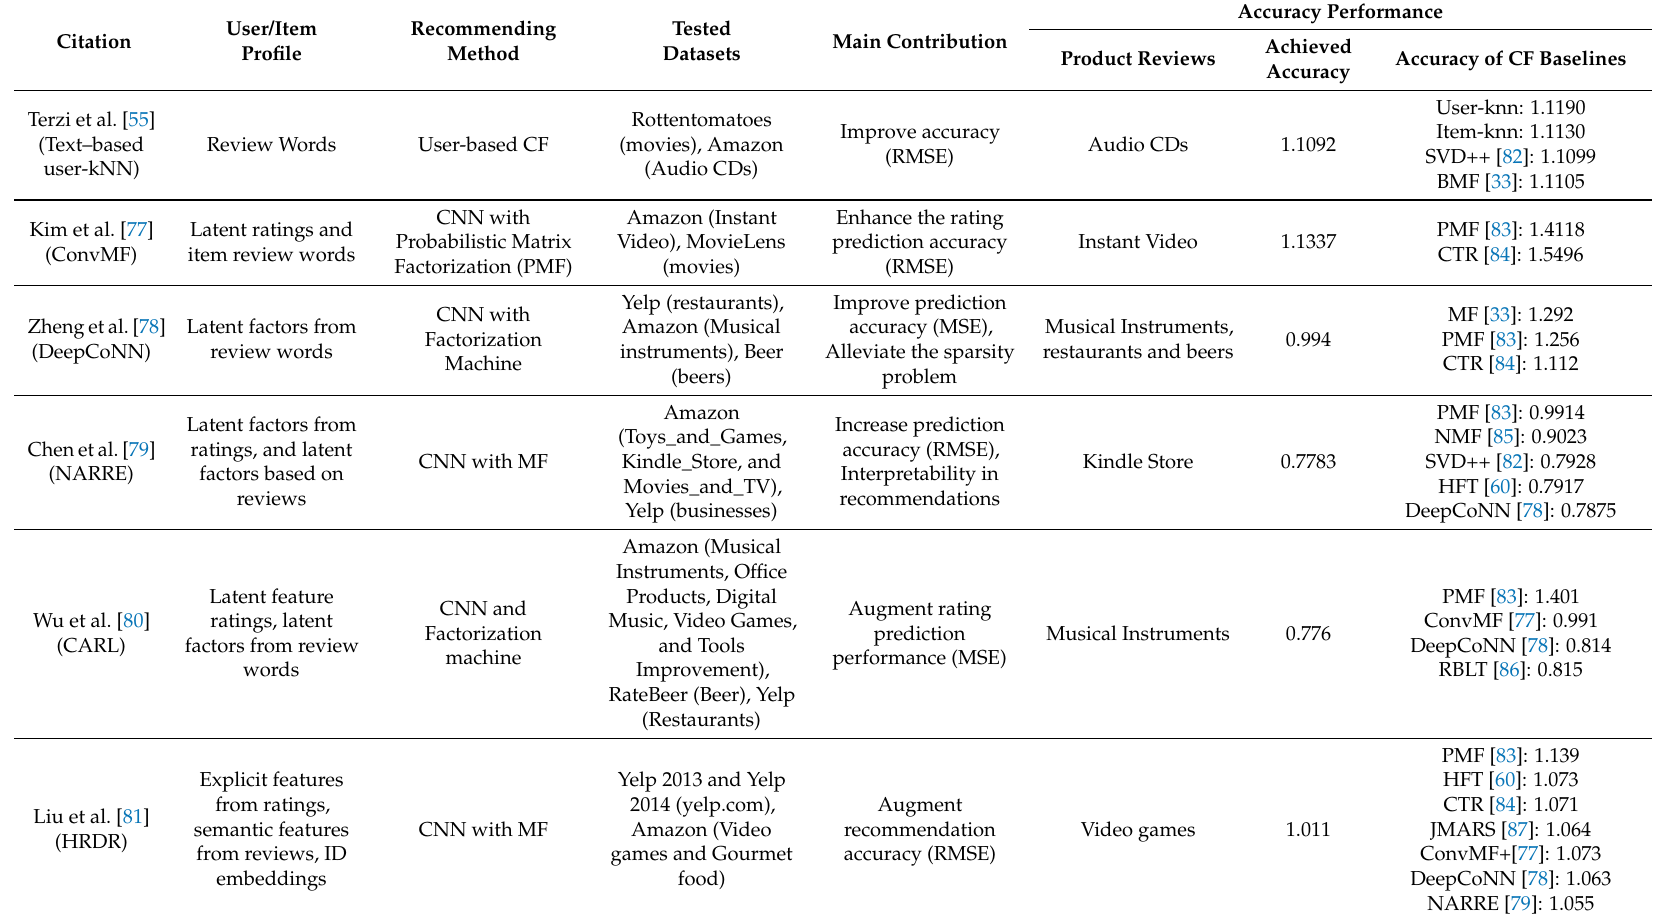
Table 3. Related works on techniques based on review